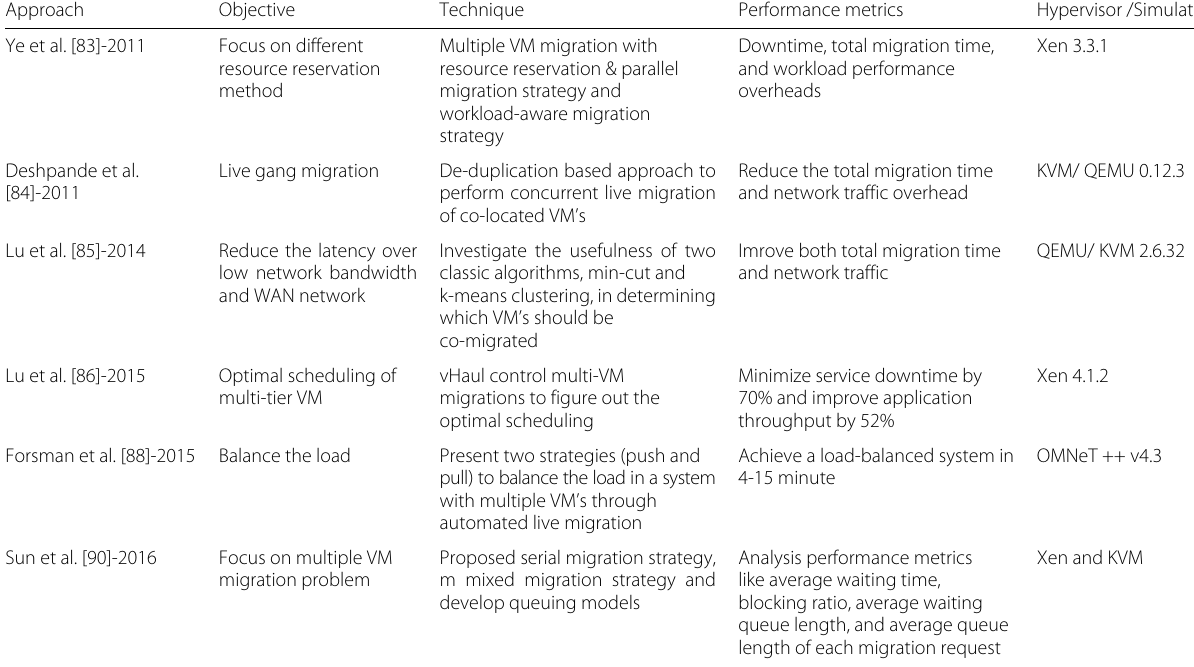
Table 4 Comparison of Multiple VM migration approaches